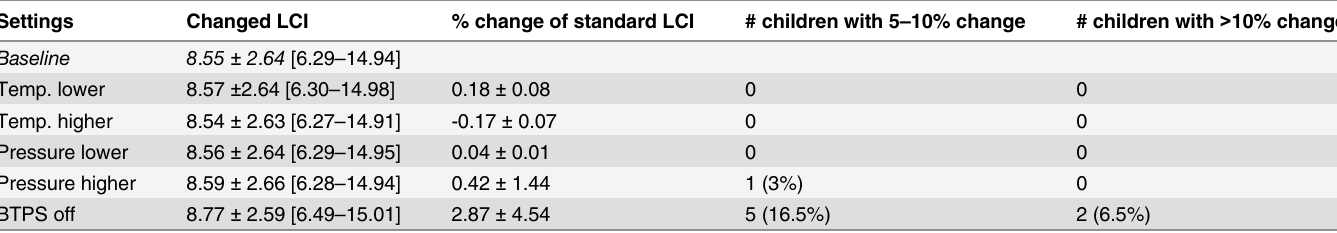
Table 3. Effect size of the change in LCI after reanalysis with different environmental conditions. Settings